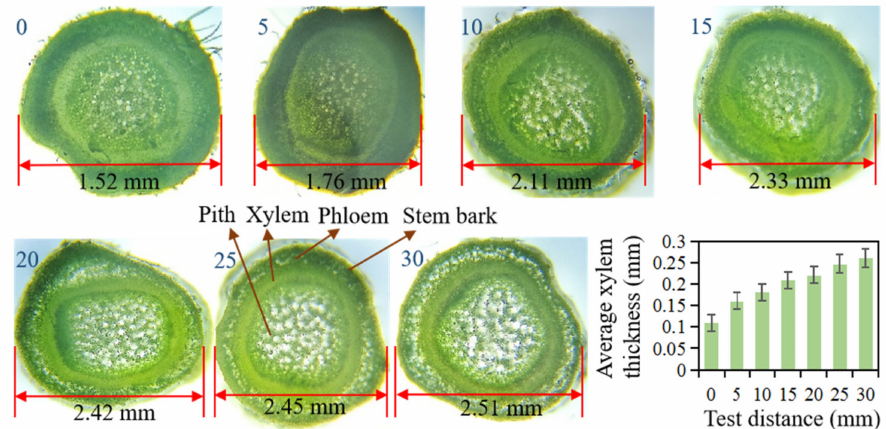
Figure 9. Microscopic cross-sectional view of different parts of tea stalks. Here, 0, 5, 10, 15, 20, 25, and 30 are distances (mm) along the stalks and indicate the positions on the stalk at which measurements were carried